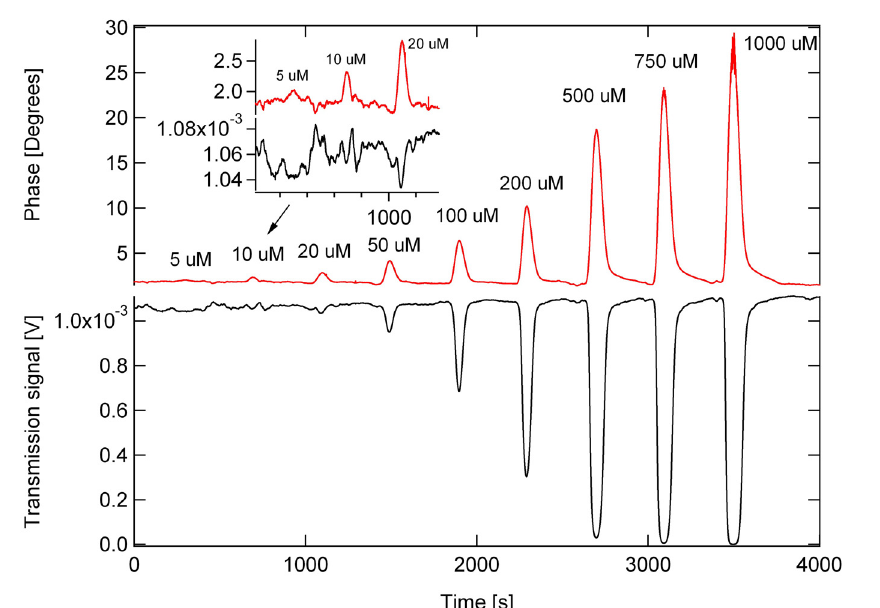
Figure 5. Measurements of tartrazine at 405 nm with phase-shift CRD (red curve, top) and single pass absorption (black, bottom). Samples (5 μ L) of different concentrations were injected into a flow of water (flow rate: 10 μ L/min) with a sample injector (Rheodyne)